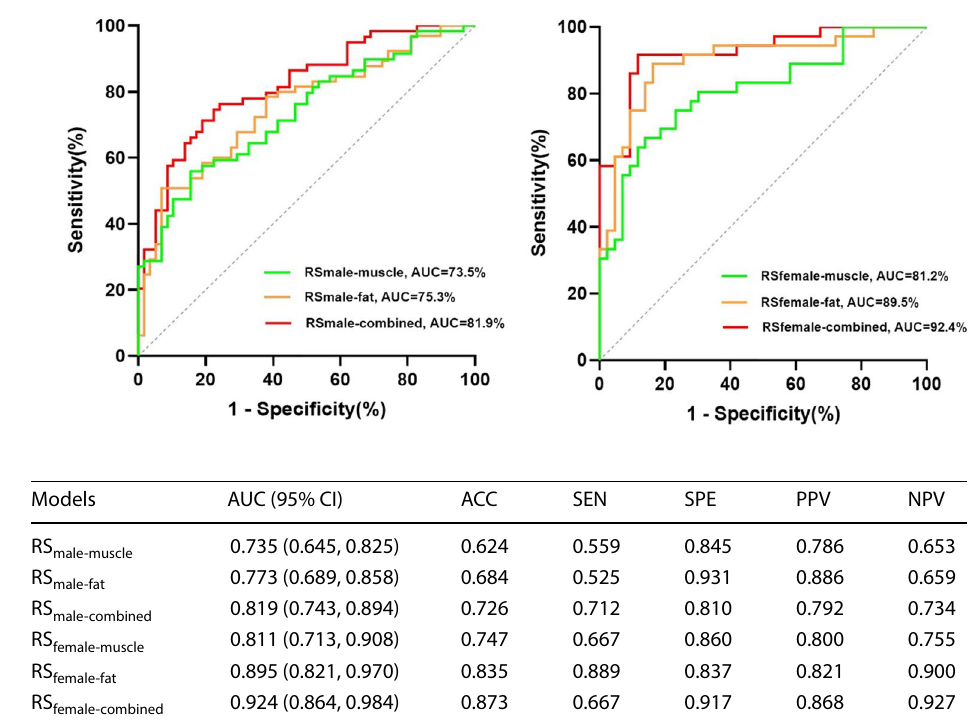
Fig. 3 Performance of radiom- ics signature. RS radiomics score, AUC area under the curve